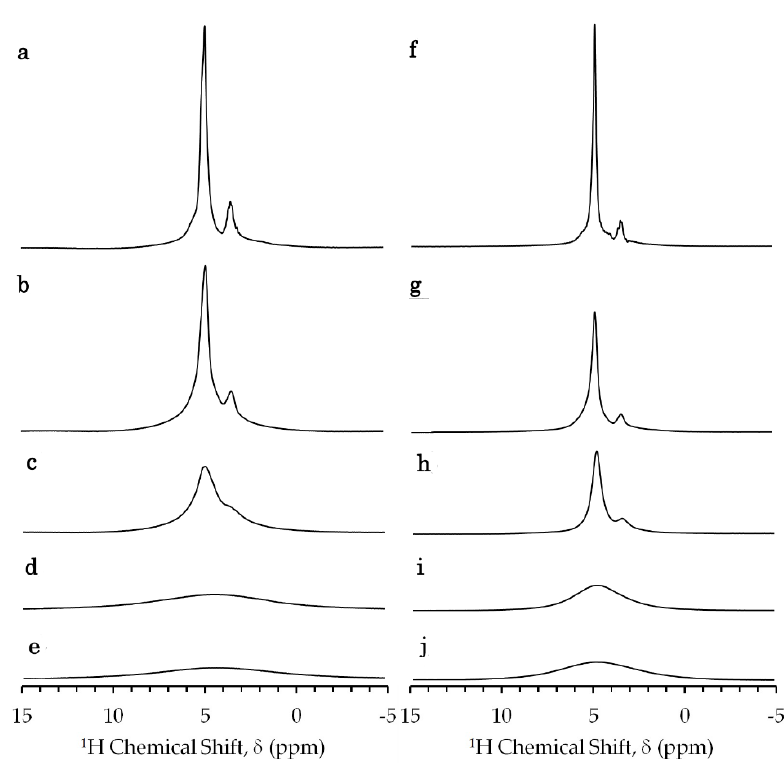
Figure 1. 1 H-NMR spectra of E. coli sample mixed with ( a – e ) aqua Gd 3 + and ( f – j ) Gd-DOTA (gadolinium-1,4,7,10-tetraazacyclododecane-1,4,7,10-tetraacete complex) obtained by a single pulse Fourier transformation method at a 1 H resonance frequency of 700 MHz and temperature of 273 K. Samples of 10 µ L of ( a ) 0, ( b ) 12, ( c ) 25, ( d ) 149 and ( e ) 250 mM aqua Gd 3 + solutions and 10 µ L of ( f ) 0,